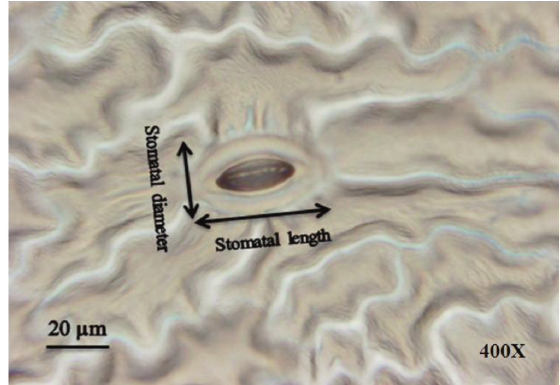
Fig. 1 - Measurement of stomata (length and diameter) with light microscope magnification